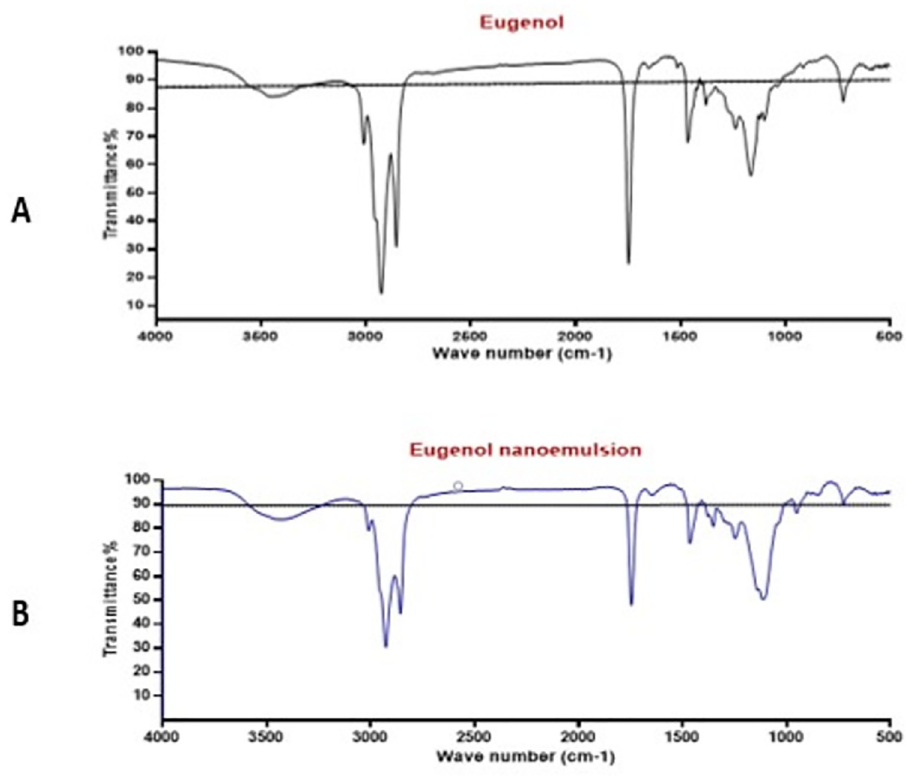
Fig 3. FTIR spectra of Eug and formulated